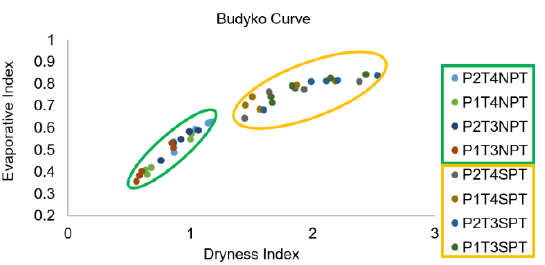
Figure 8. Budyko curve by sensitivity analysis tests. P1—WorClim; P2—SNIRH; T3—E1; T4—E2; Green Cluster: NPT (PTRH1, PTRH2, PTRH3, PTRH4); Yellow Cluster: SPT (PTRH5, PTRH6, PTRH7, PTRH8).